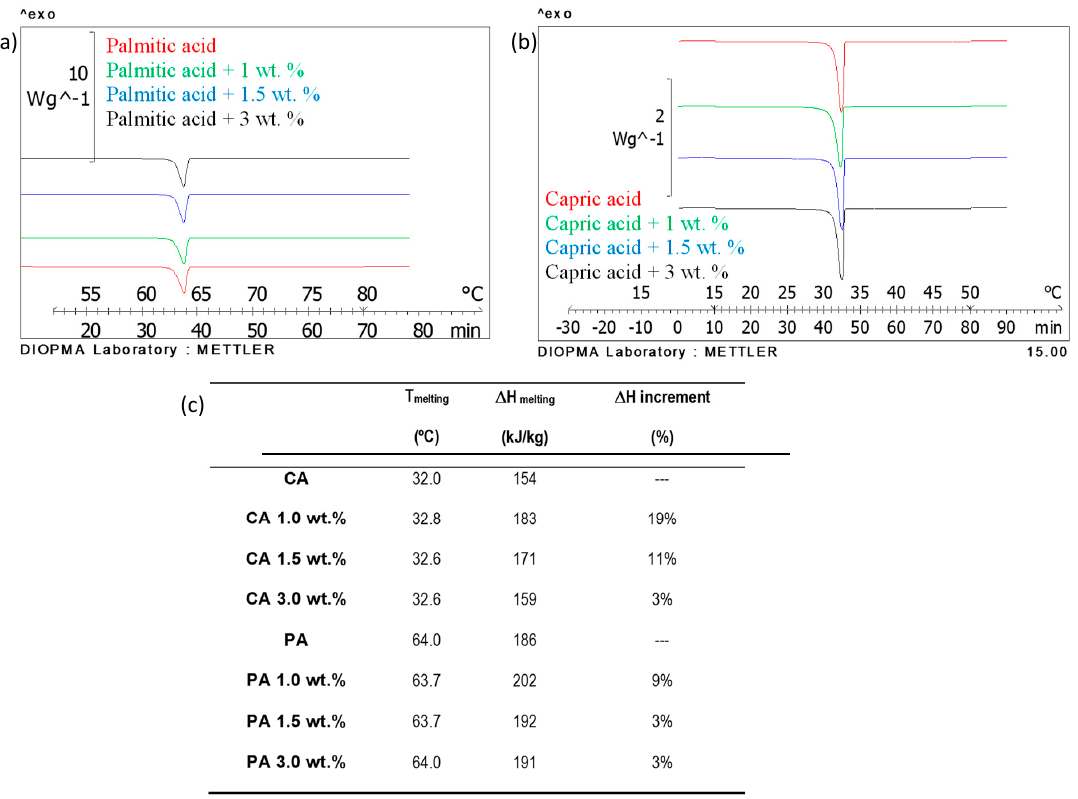
Figure 7. Differential scanning calorimeters (DSC) results of NEPCM manufactured in this study: ( a ) DSC results of palmitic acid samples, ( b ) DSC results of capric acid samples, ( c ) DSC results summary.